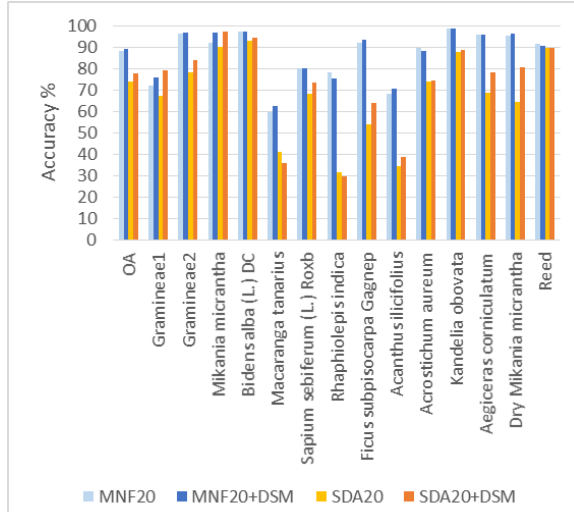
Figure 2. Overall and producer’s accuracy of before and after adding DSM data by SVM Classifier